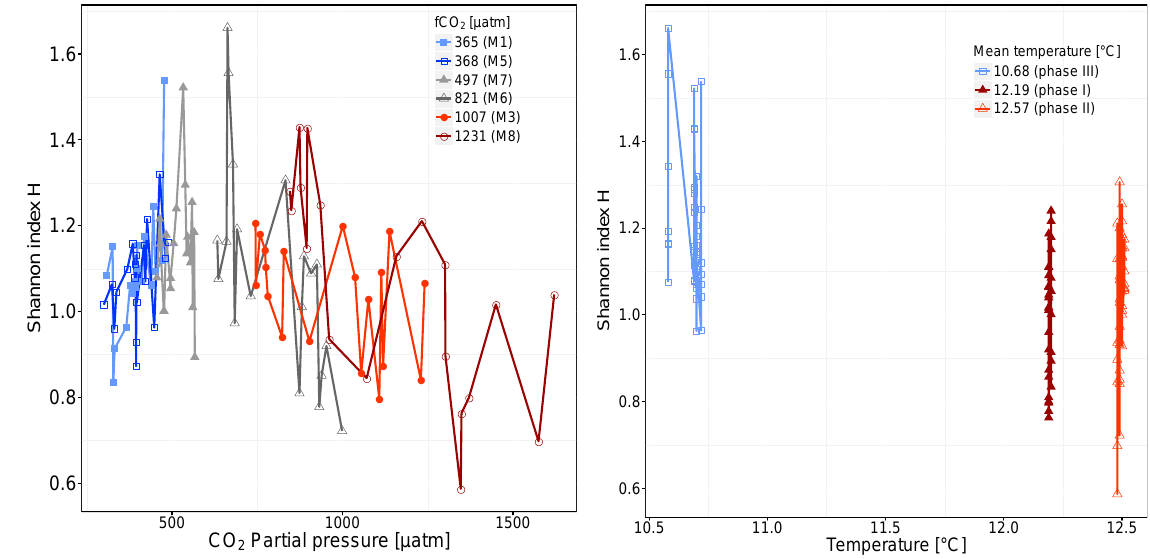
Figure 4. Left: ciliates, graphical depiction of statistical results for Shannon diversity index H as a function of f CO 2 . H is shown in relation to the daily change of f CO 2 . Symbols and colors identify the mean f CO 2 for each mesocosm. Right: ciliates, graphical depiction of statistical results for Shannon diversity index H as a function of temperature. For better visibility, H is plotted against the mean phase (I, II, III) temperature of each mesocosm. Symbols and colors identify mean phase temperature across all mesocosms.